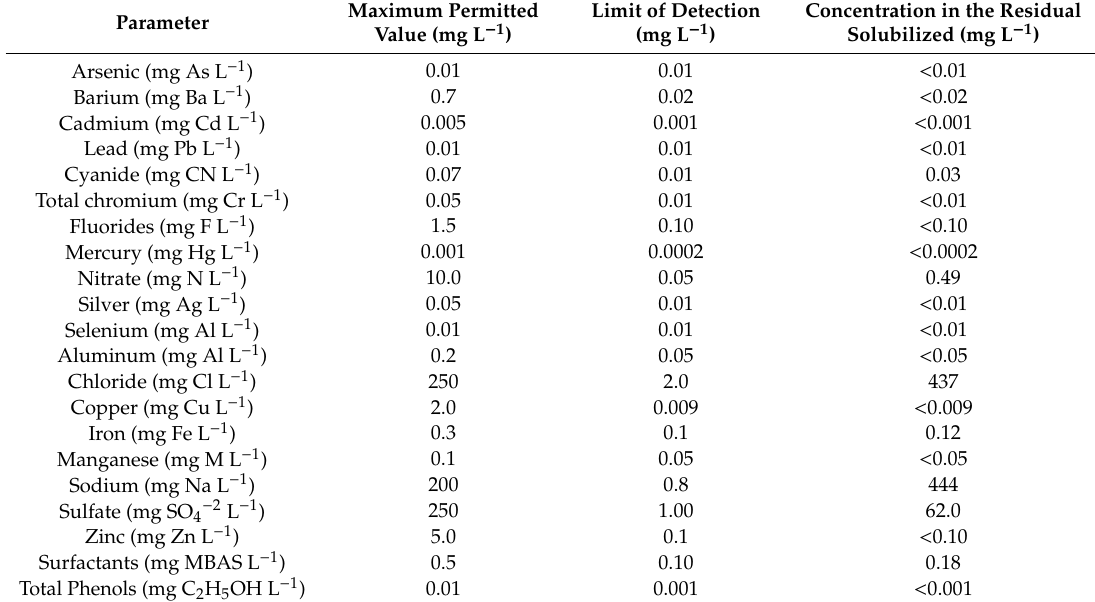
Table 4. Classification of solubility toxicity—inorganic parameters, measured by chromatography: maximum permitted value, limit of detection, and concentration of solubility in the sample, according to the Standard Methods for Examination of Water and Wastewater, 20th ed. [9].